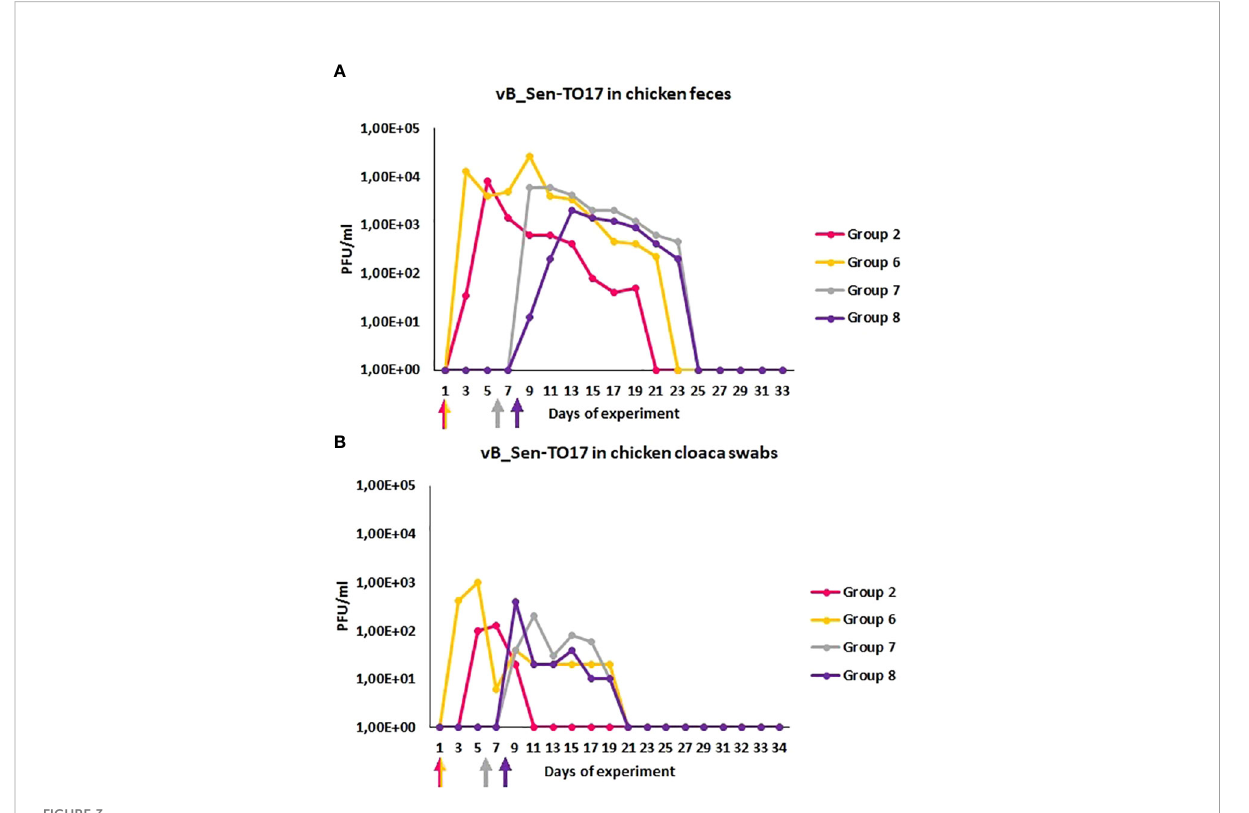
FIGURE 3 Prevalence of phage vB_Sen-TO17 (PFU/ml) in chicken feces (A) and cloaca swabs (B) during the experimental phage therapy. The days the groups began phage therapy are marked with arrows corresponding with colors of the group on the